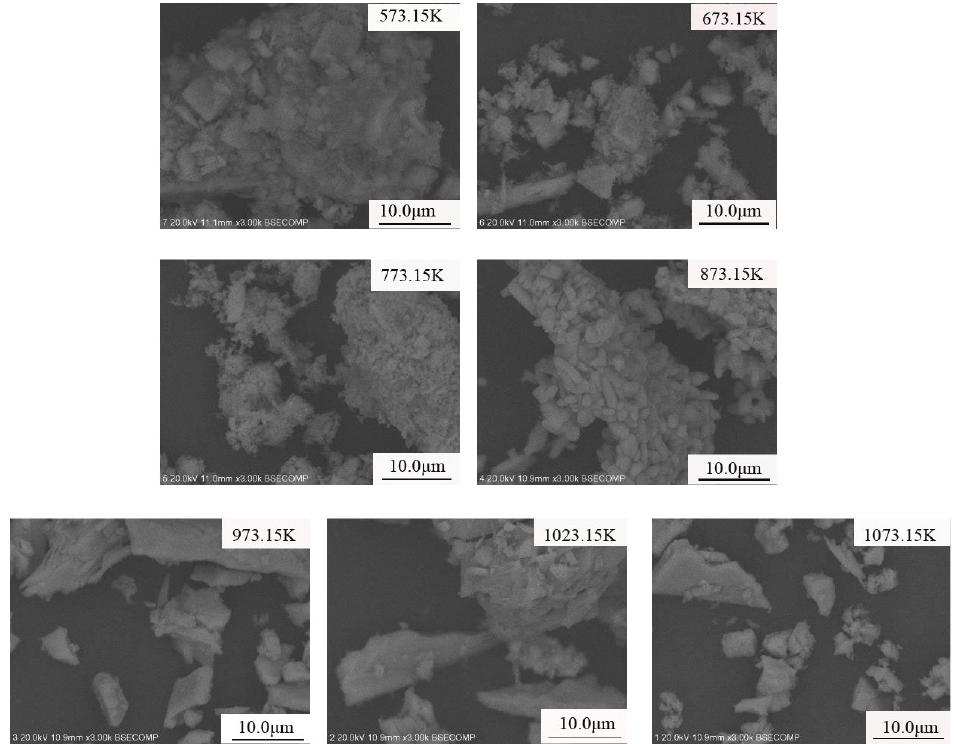
Figure 5. The SEM images of sample roasted at different temperatures for 1 hour with the molar ratio of 1:1 between V